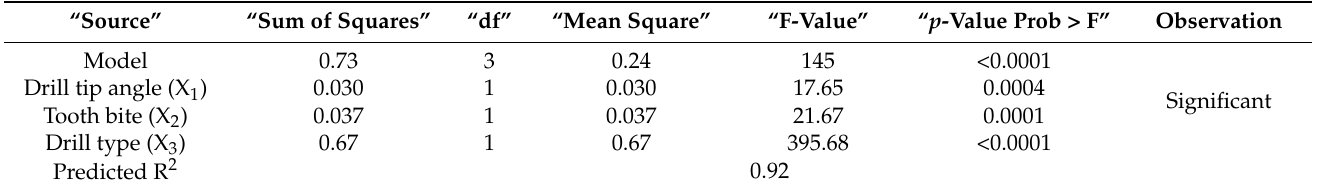
Table 5. Analysis of variance results for the regression equation in the case of the delamination factor at the outlet.